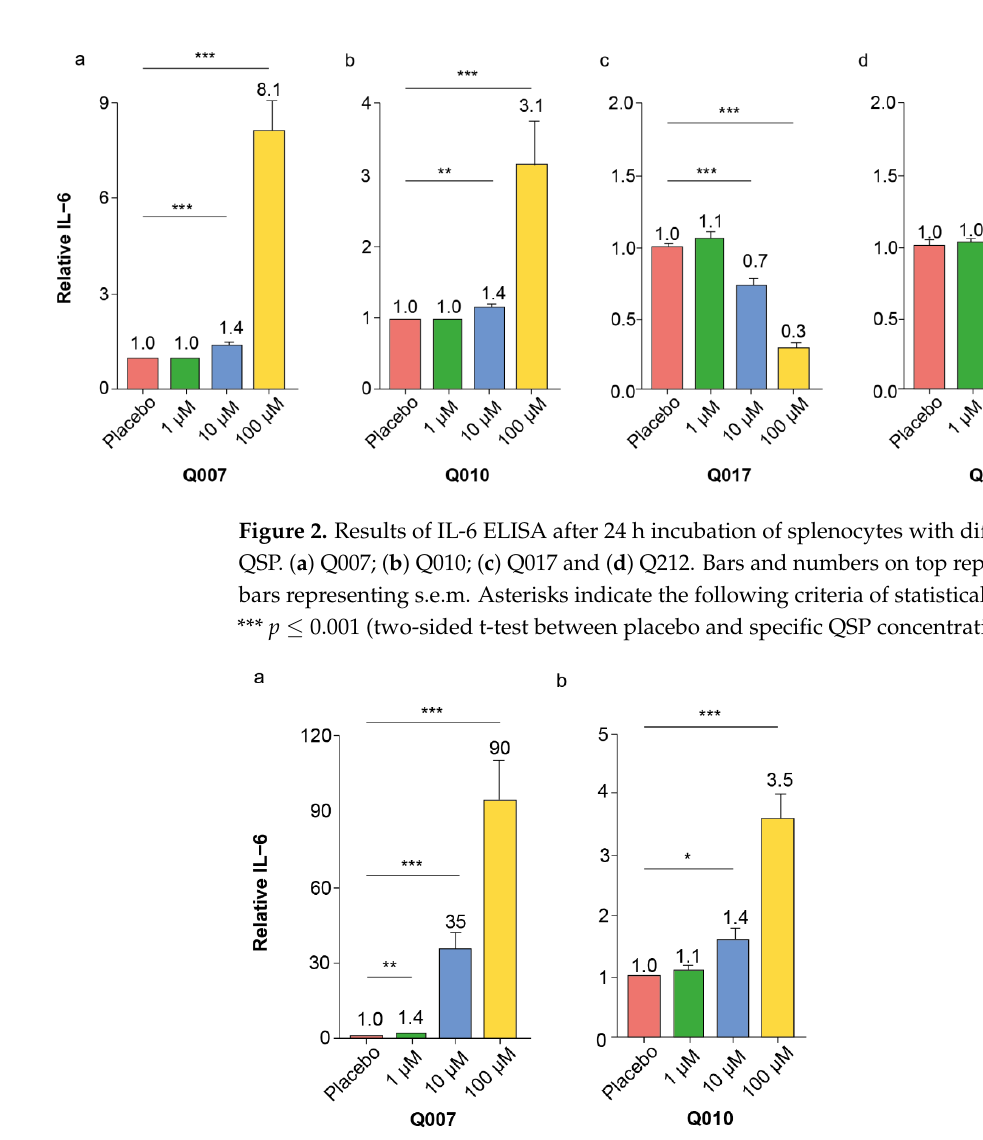
8 of 15 Figure 1. Heat plot of inflammatory screening on splenocytes and J774 cells. The y -axis represents all QSPs, while the x -axis represents the different experiments and the global inflammatory z-score (rightmost column). Each experiment is named based on its measured cytokine (IL- 6 or TNFα), used cell type (spleen or J774) and incubation time (24 or 40 h). QSP concentration is 100 nM for all ex- periments. The colours are based on the z-score for each QSP in a specific experiment or overall for the column “z_inflammatory”. Missing data are indicated in faint yellow. 3.2. The Inflammatory Activity of Selected QSP Hits Was Confirmed and Dose-Dependent The four QSP with the highest overall inflammatory z-scores (Q007, Q010, Q017 and Q212) from the different screening experiments were re-assessed at different concentra- tions (1 µM, 10 µM and 100 µM) on splenocytes of different ages. Figure 2 shows the pooled results, while an exploratory subgroup analysis per age is provided in Supplemen- tary Figure S1. The IL-6 pro-inflammatory effects of Q007 and Q010 could be confirmed,